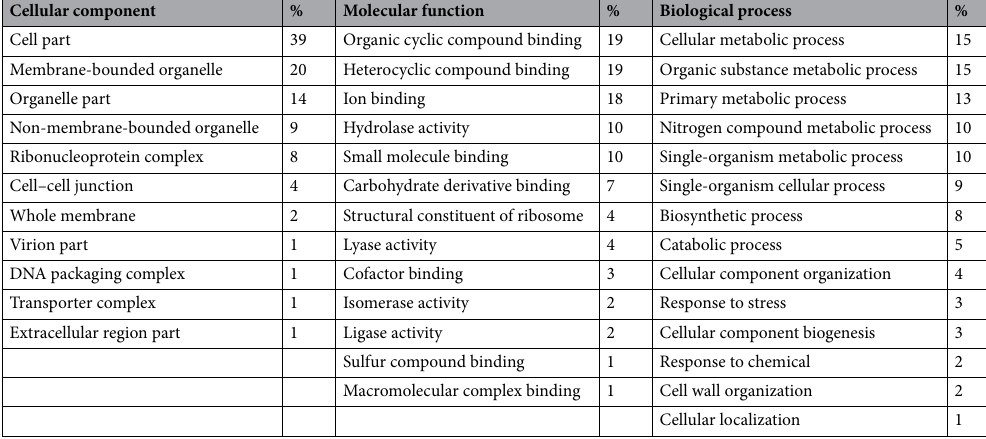
Table 3. GO annotation and percentage of differential expressed proteins in high potassium treatment.